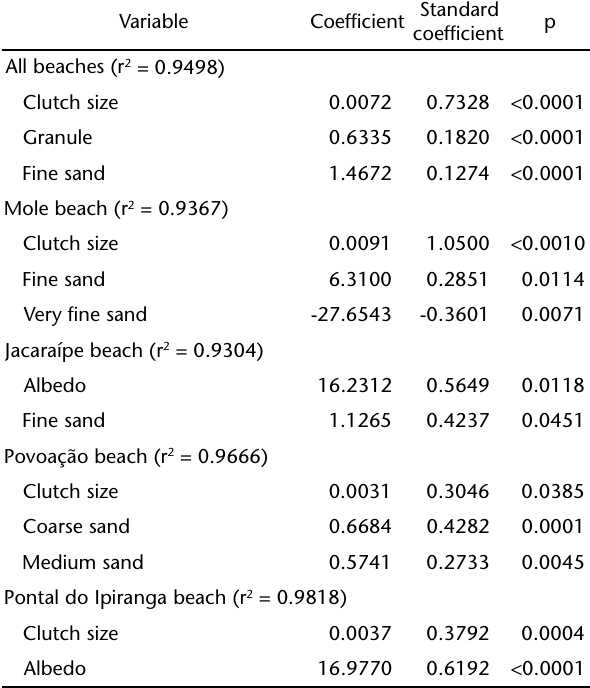
Table II. Stepwise backwards multiple linear regression for hatchings success of C. caretta in all beaches and in each